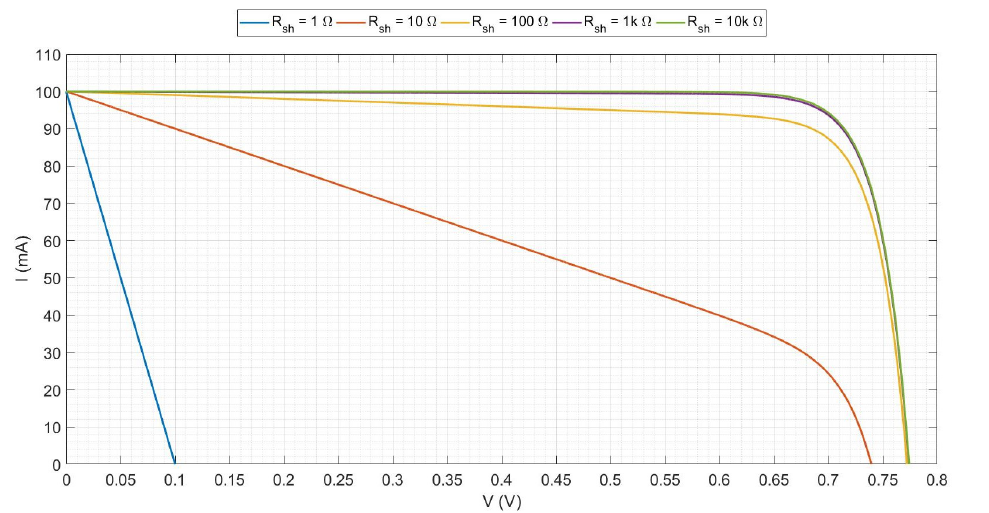
Figure 8. Example of I(V) curves for different values of R sh : the effect of the shunt resistance on the current–voltage characteristic.